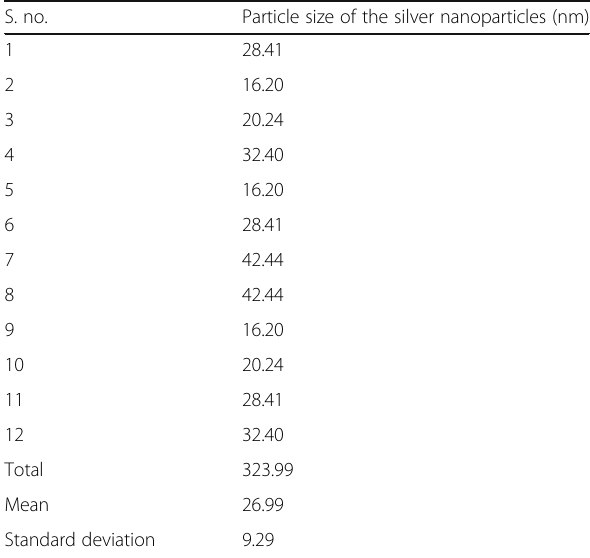
Table 1 Size of silver nanoparticles fabricated by chemical reduction